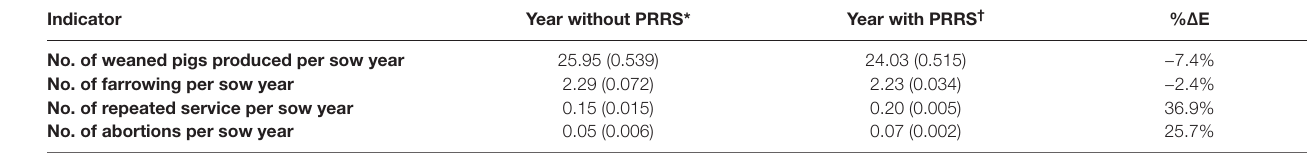
taBle 2 | Estimated means of sow efficiency comparing years in absence and presence of a PRRS outbreak. indicator Year without